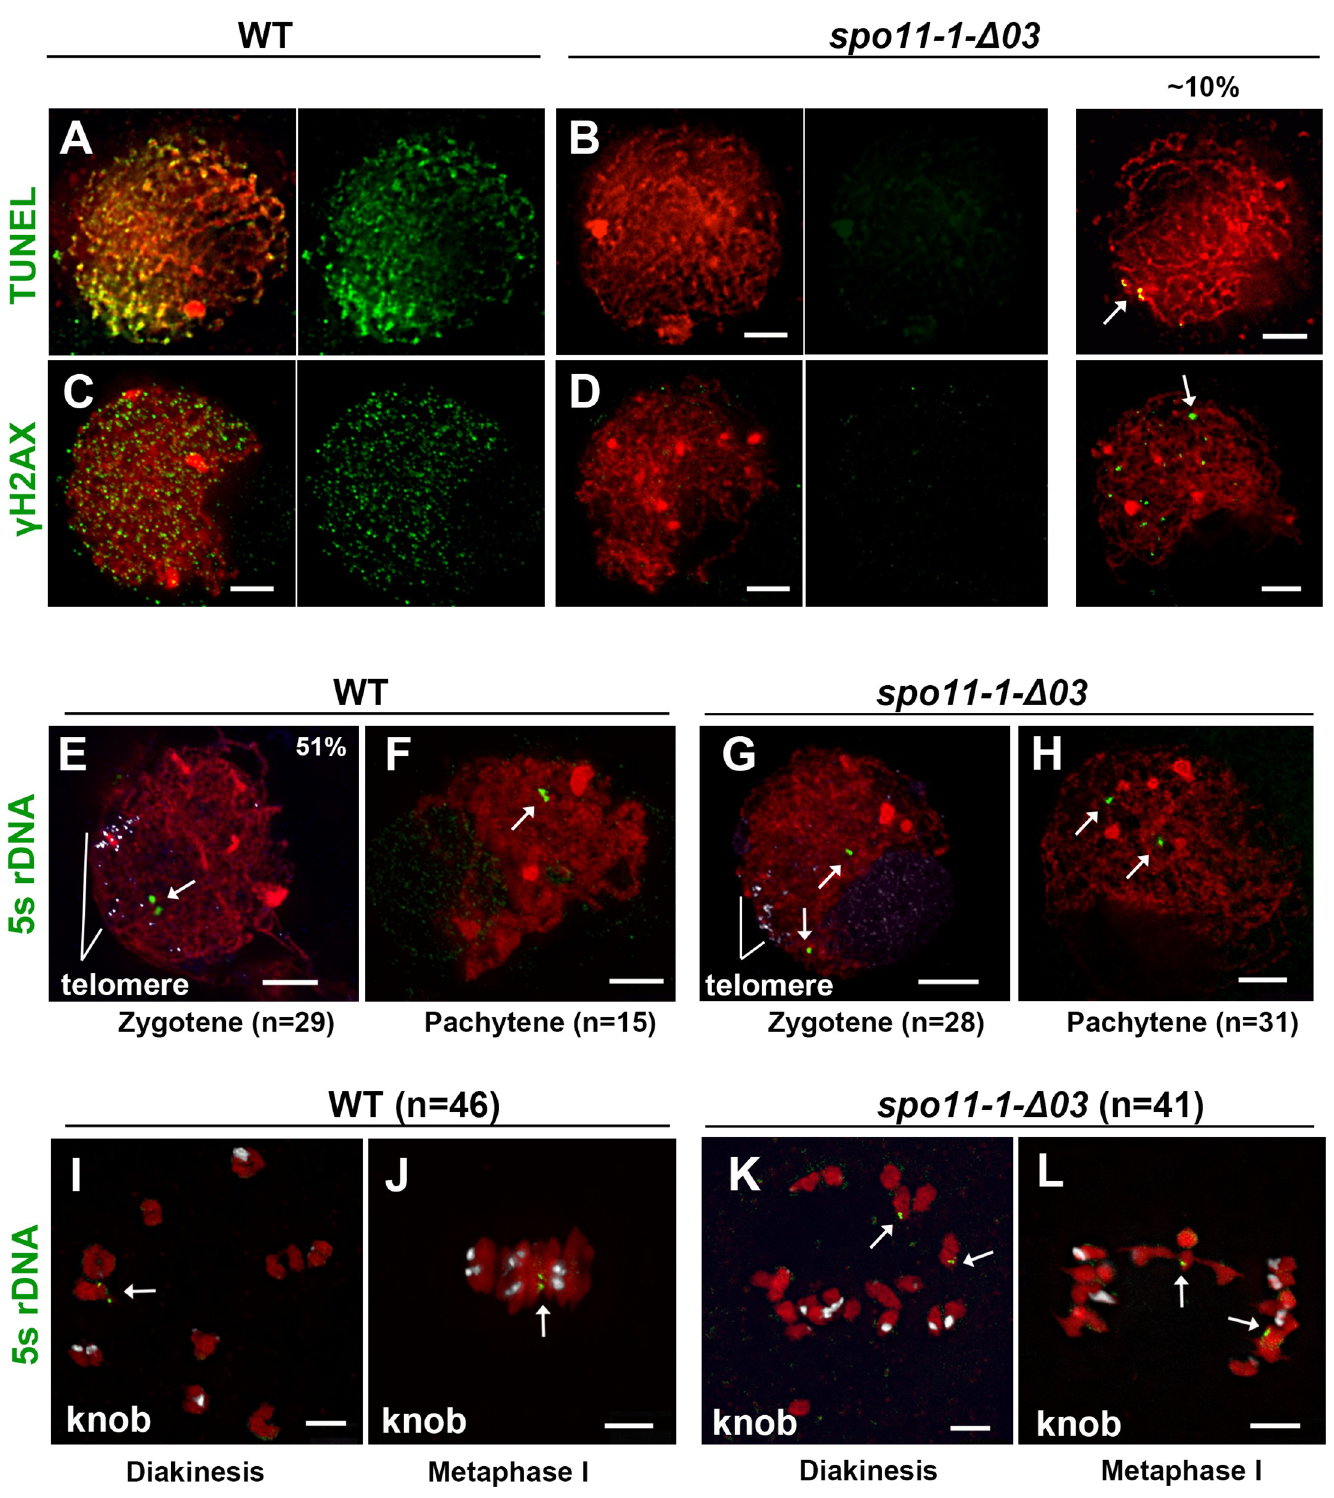
Fig 3. SPO11-1 deletion affects DSB formation, chromosome pairing and homologous recombination. (A-D) Zygotene-stage meiocytes of WT (A, C) and the spo11-1- Δ 03 mutant (B, D) showing TUNEL (A, B), γ H2AX signals (C, D) in green and DAPI stained chromatin in red. Most mutant cells exhibited no signal, but ~10% of cells exhibited a few signals (arrows). (E-H) Meiocytes at zygotene and pachytene stages from WT and spo11-1- Δ 03 hybridized with 5S rDNA (green, arrows) and telomere probes (white signals in E and G) demonstrate impaired homologous pairing in the spo11-1 mutant, although telomeres cluster normally. (I-L)